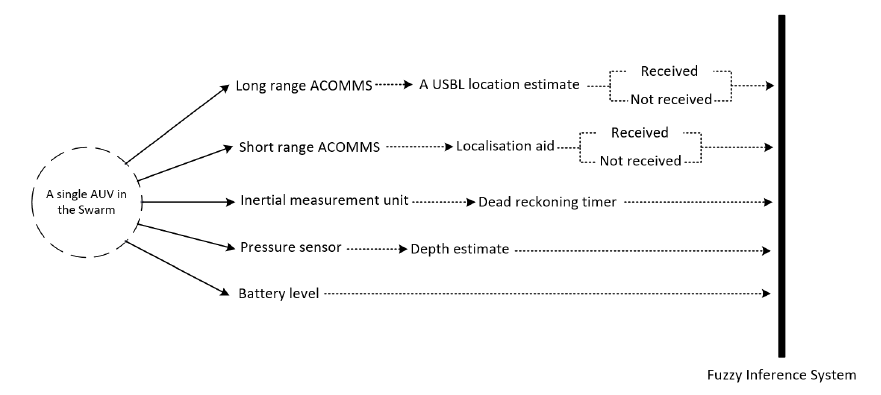
Figure 10. Fuzzy inference variable inputs of each AUV in a swarm of AUVs based on its on-board acoustic communication modems and